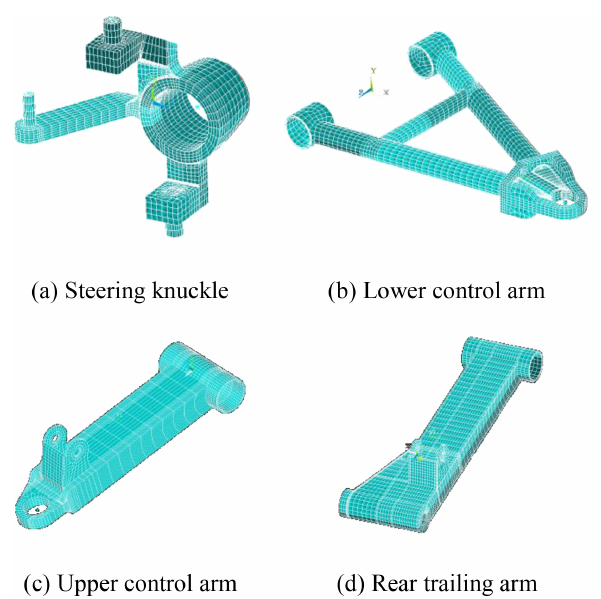
Figure 6. Meshed models of compliant members of front and rear